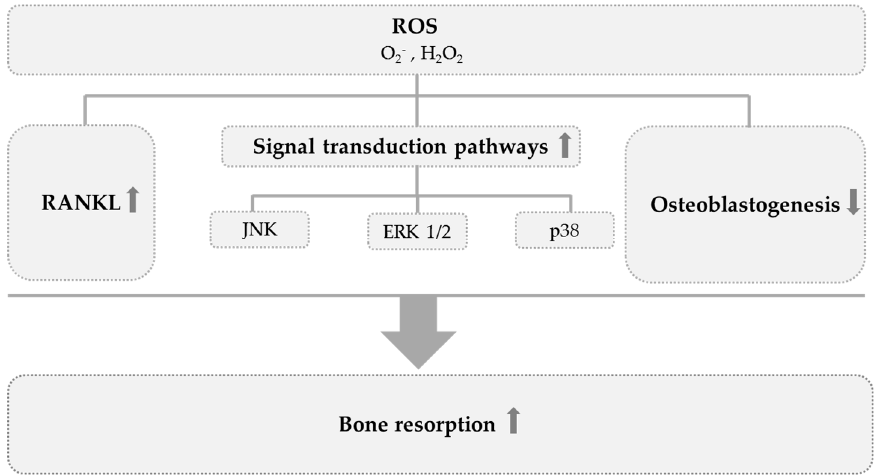
Figure 1. Impact of reactive oxygen species (ROS) on bone turnover [8–14]. ROS promote bone resorption by enhancing receptor activator of nuclear factor-kappa B ligand [RANKL]-induced osteoclast activity, by activation of osteoclastogenesis related signal transduction cascades (c-Jun N-terminal kinase (JNK), p38 mitogen-activated protein kinases (p38), extracellular signal-regulated kinase (ERK 1/2)), and by suppressing osteoblastogenesis. ↑ , activation; ↓ inhibition